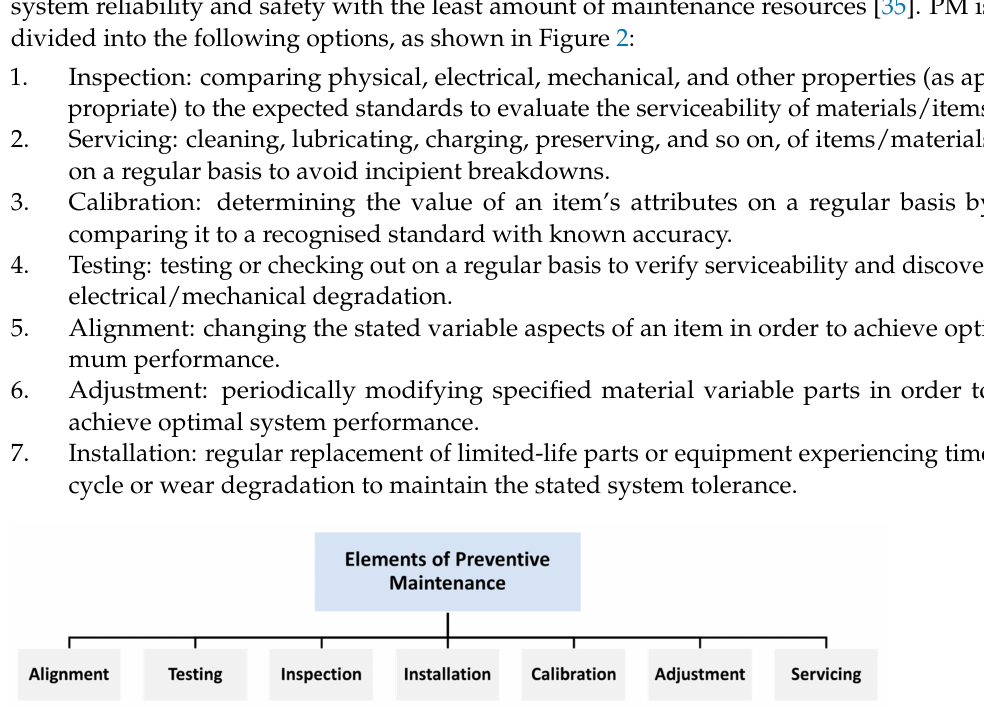
Figure 2. Elements of preventive